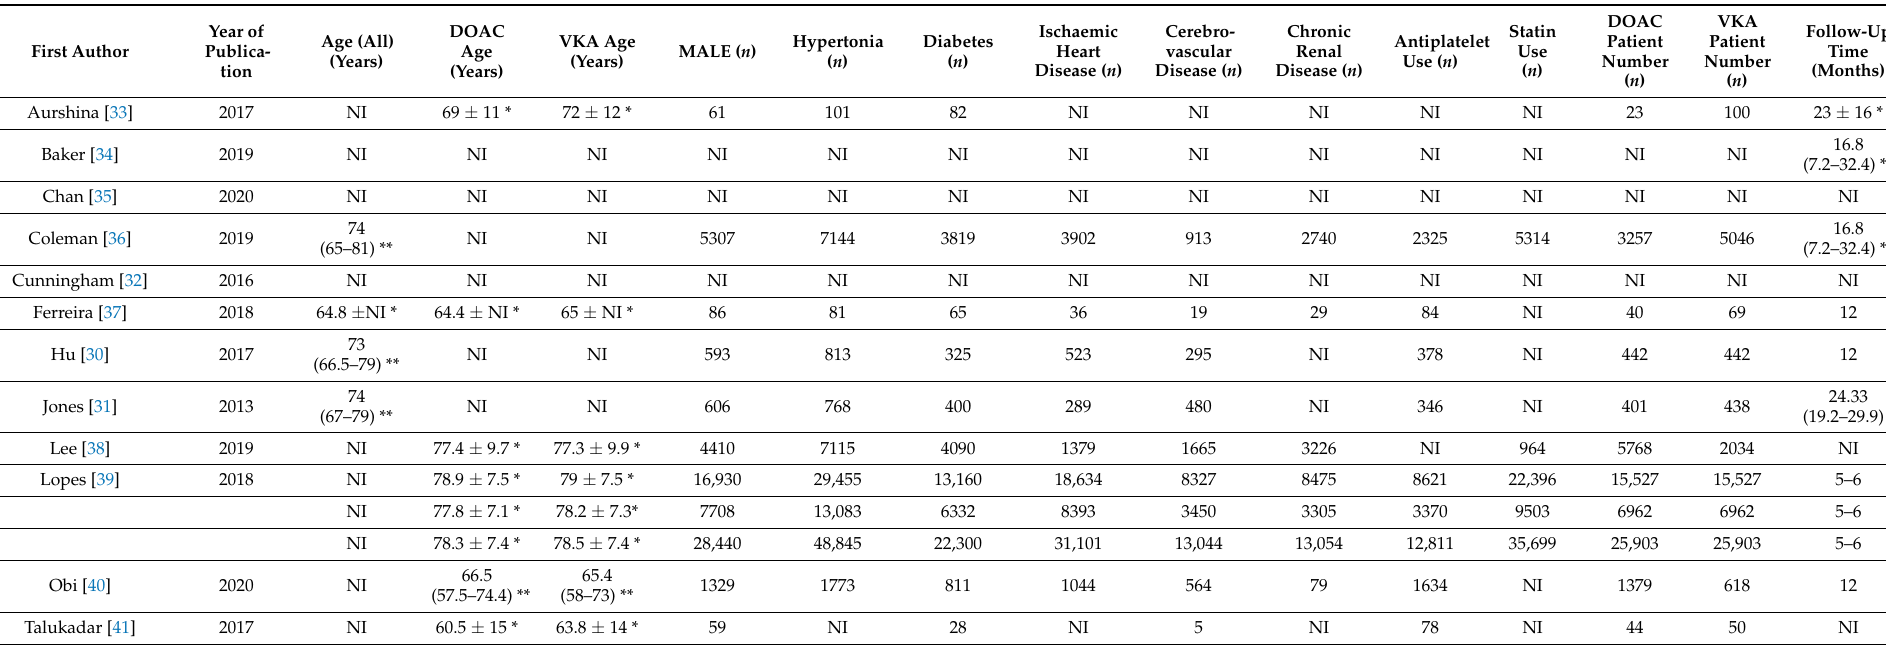
Table 2. Basic characteristics and patient demographics; parameters expressed as mean with standard deviation (*), or median with interquartile range